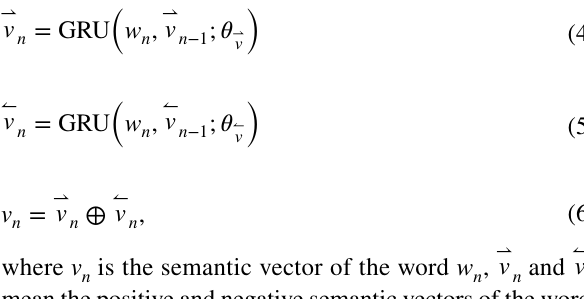
Fig. 3 BGAM: the structure of text representation model based on semantically represents word sequences composed of mul- tiple word embedding vectors w n from both positive and